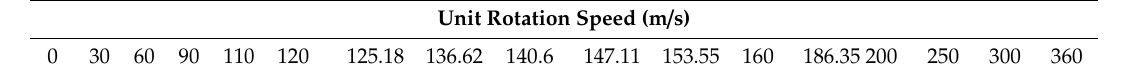
Table A4. The unit rotation speed